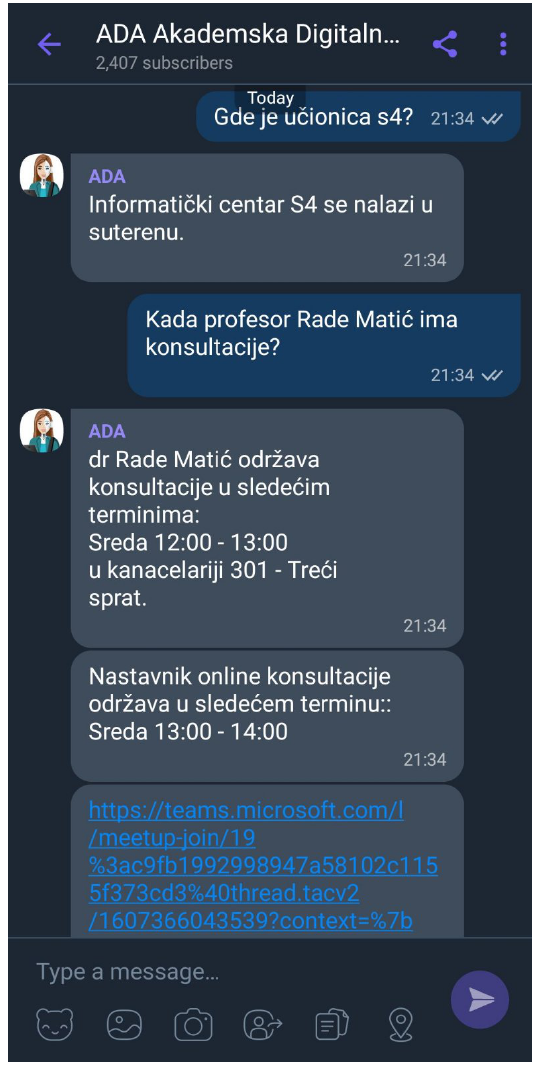
Figure 9. ADA (Academic Digital assistant) chatbot, implemented in the Belgrade Business and Arts Academy of Applied